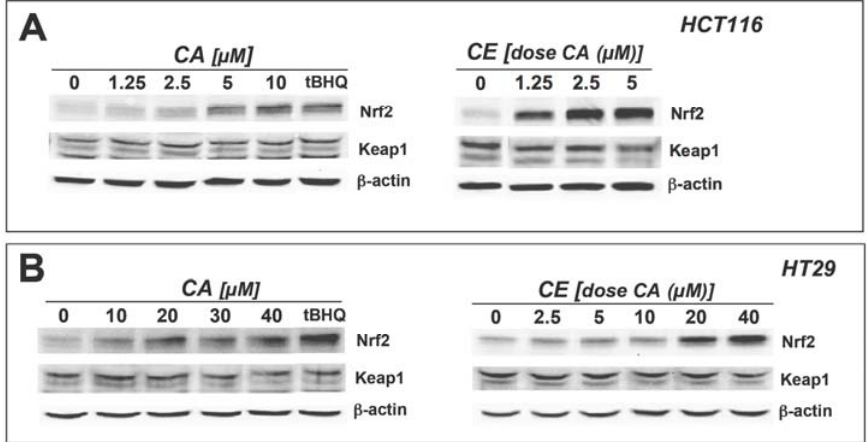
Figure 3. Upregulation of Nrf2 protein levels in cultured human colon cancer cells exposed to cinnamic aldehyde and ethanolic cinnamon extract. Cultured human HCT116 (a) and HT29 cells (b) were treated for 4 h with either CA or CE at the indicated doses normalized for CA content. Treatment with tBHQ (100 µM, 4 h) served as a positive control. Equal loading was assessed by immunodetection of 